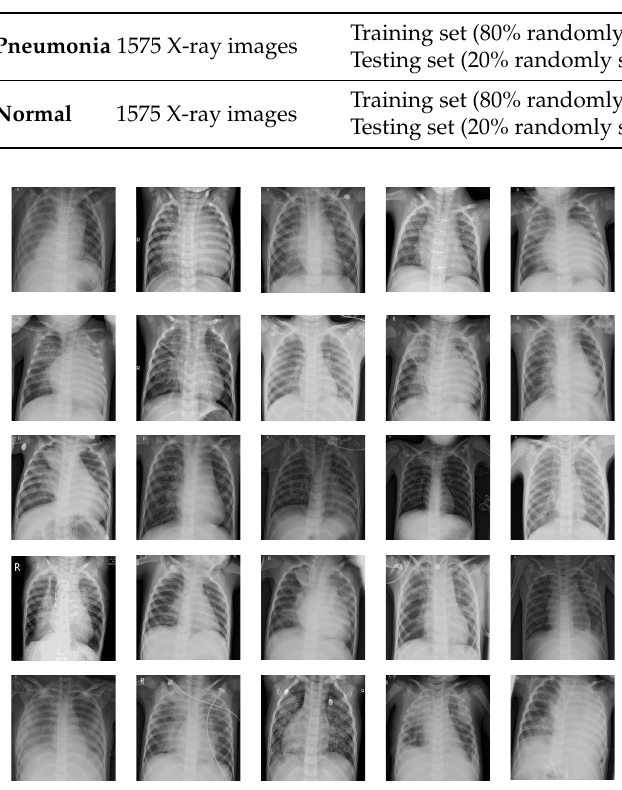
Table 4. Details of the datasets.